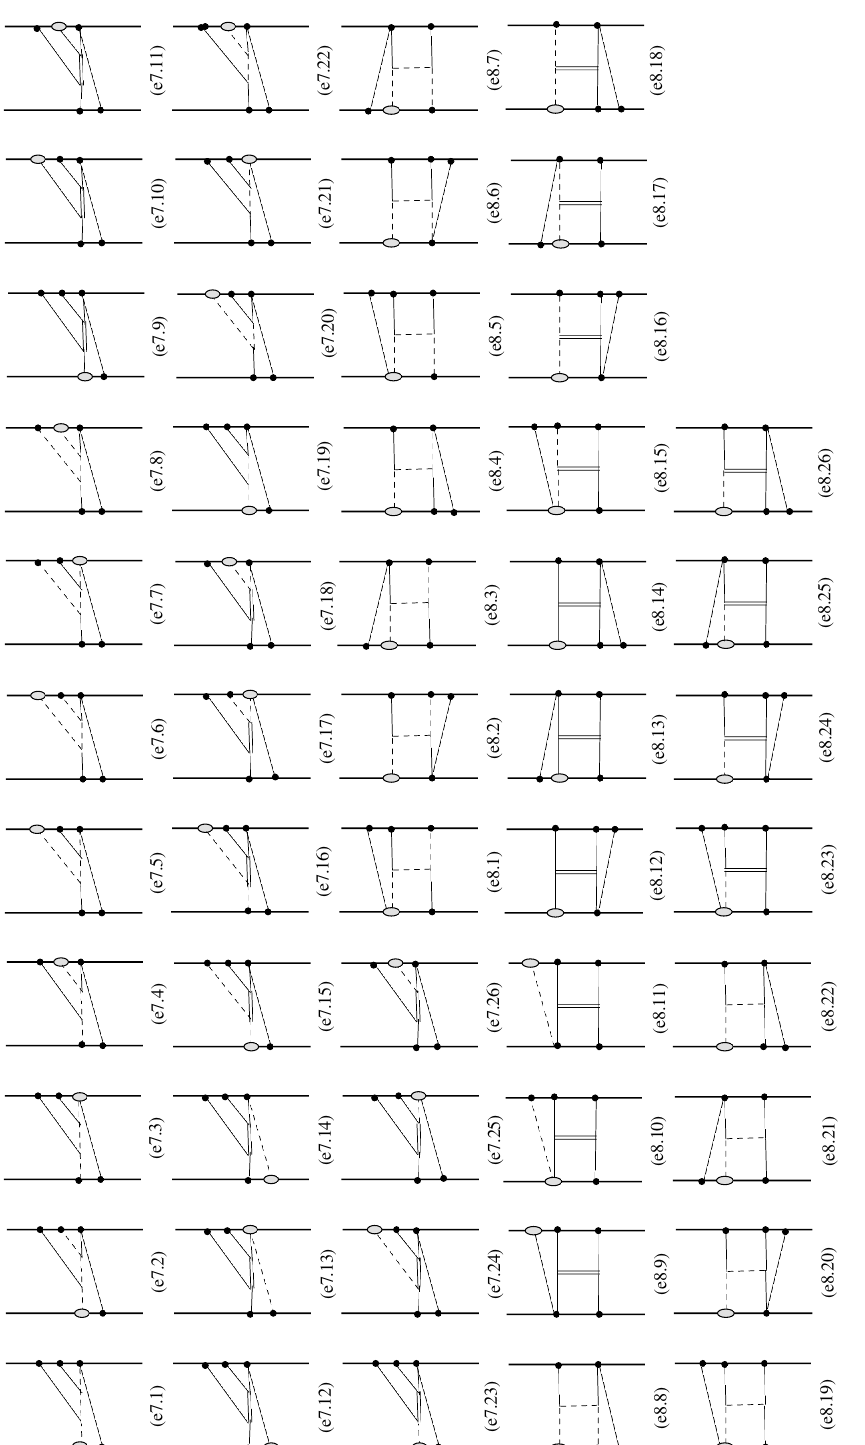
Figure 8 . Feynman graphs which contribute to the N 3 LO spin-orbit coupling at G 4 . This figure contains all graphs with topologies (e7) and (e8) of figure 4. The graphs in group (e8) are rank-two graphs, which clearly factorize into the single rank-two topology (d3) in figure 3.